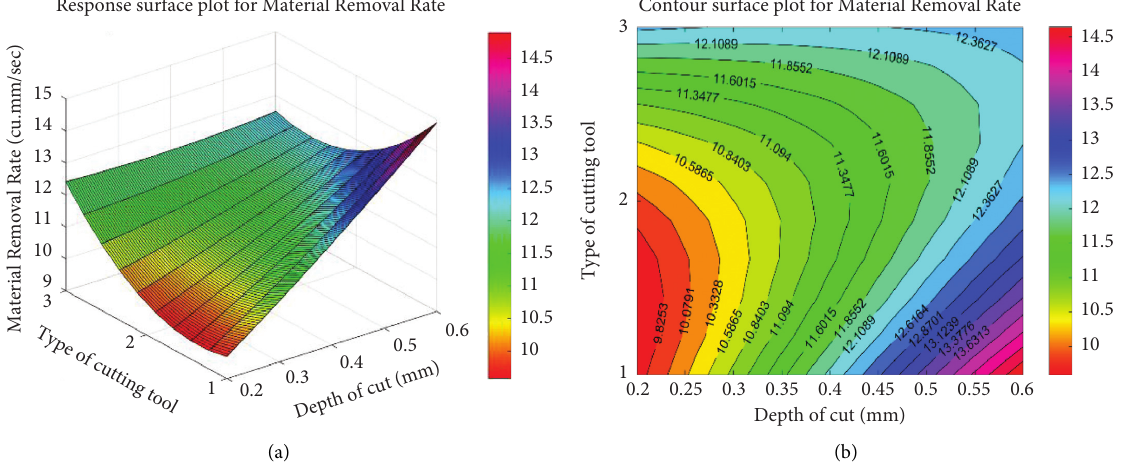
Figure 6: (a)Response surface graph for MRR (type of cutting tool vs. depth of cut). (b)Contour surface plot for MRR (type of cutting tool vs. depth of cut). Table 11: Regression model and summary results for torque.